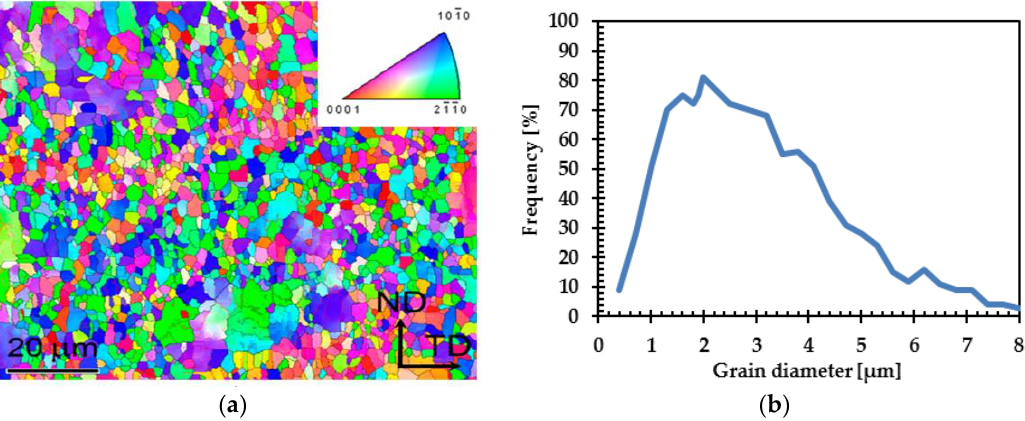
Figure 10. Electron backscatter diffraction (EBSD) map of TCAP sample after the third pass with IPF color-coding with respect to TD. Black and red lines indicate high angle grain boundaries (HAGB ’ s) and low angle grain boundaries (LAGB ’ s), respectively ( a ), and corresponding histogram ( b ).